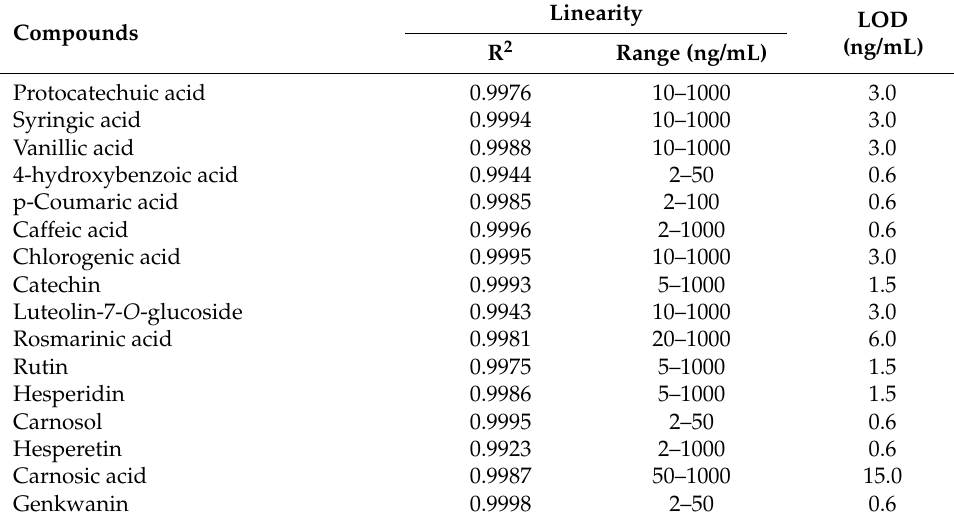
Table 1. Linearity parameters and limits of detection (LOD) of phenolic standards used for